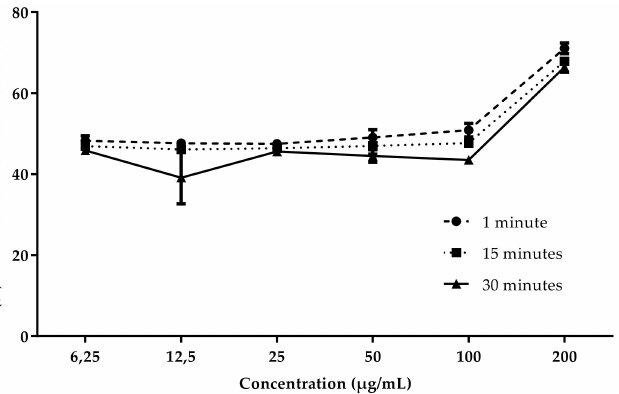
Figure 2. Concentration-dependent AChE inhibitory activity of methanolic extract of A. squamosa seeds.